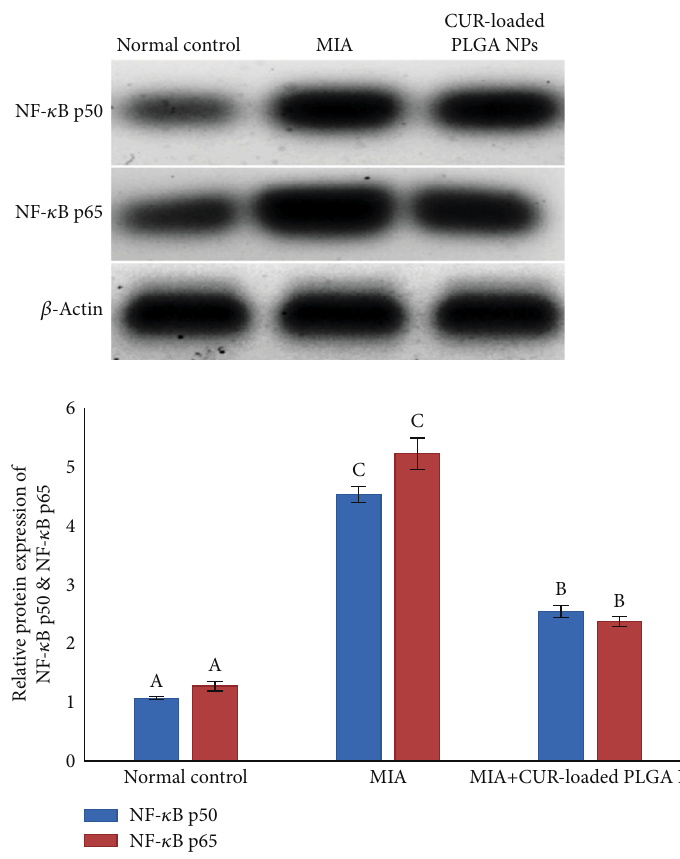
Figure 7: E ff ect of CUR-loaded PLGA NPs on the relative protein expression levels of NF- κ B p50 and NF- κ B p65 of MIA-induced OA rats. Means, which have di ff erent symbols (letters), are signi fi cantly di ff erent at P < 0 : 05